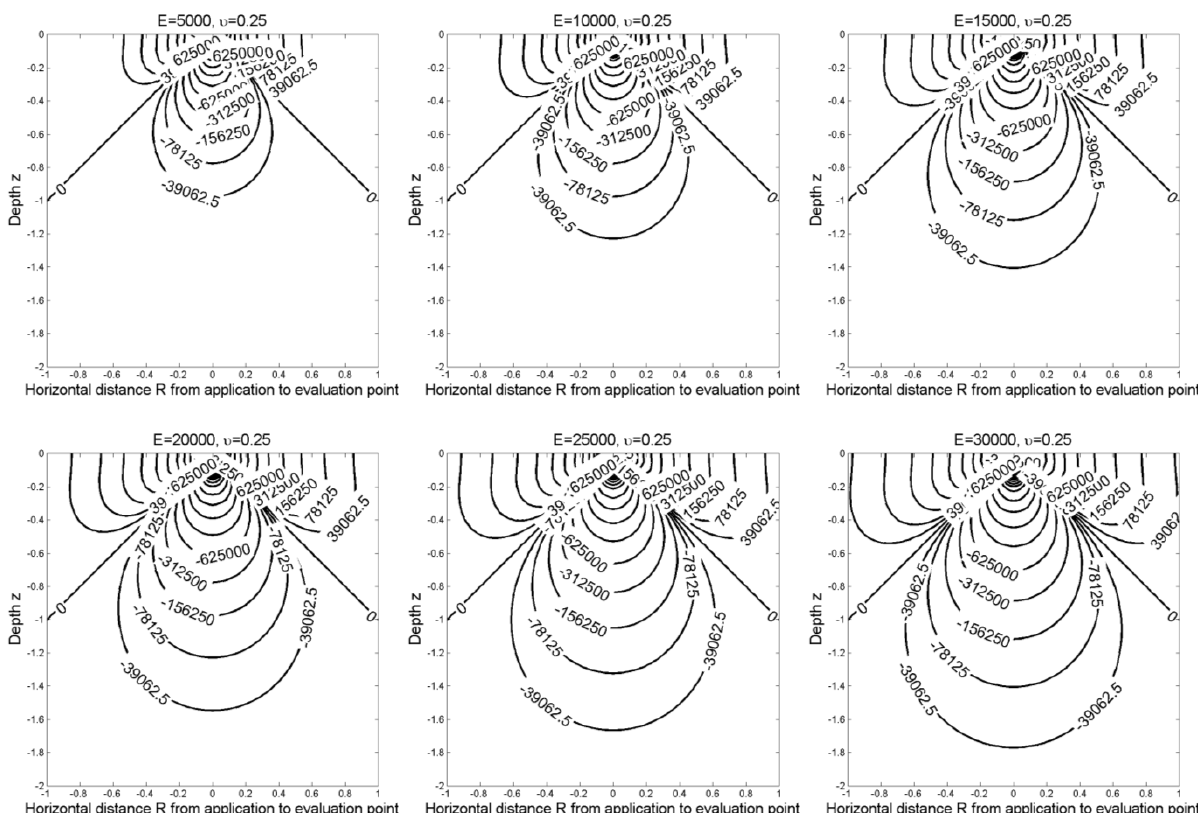
Figure 6: Parametric analysis on E for the vertical stress contours (all distances in mm) (from [6]).